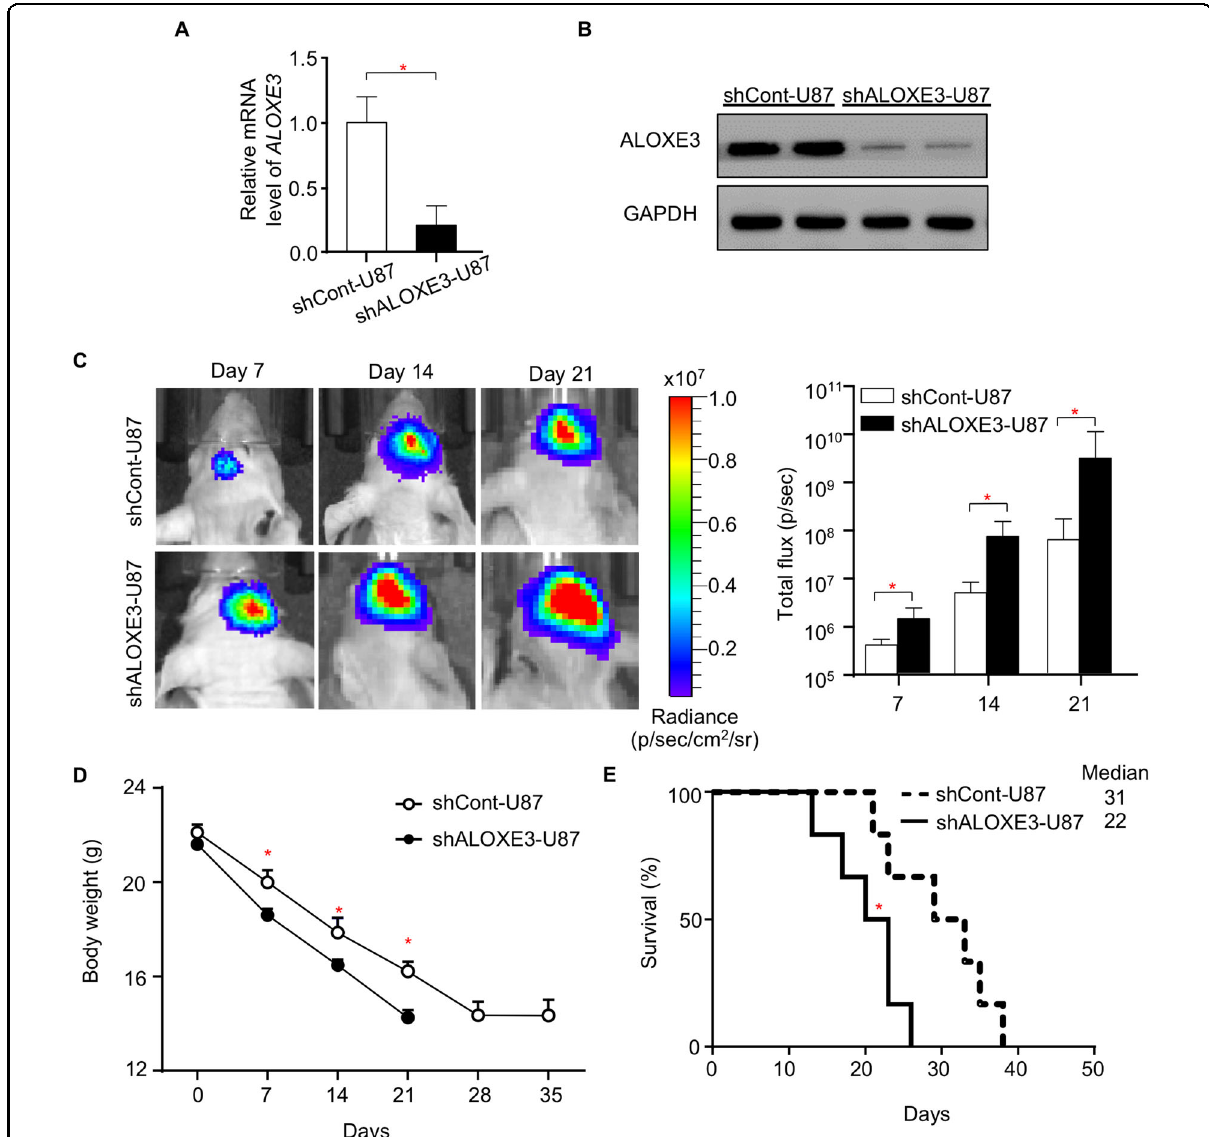
Fig. 2 ALOXE3 de fi ciency promotes orthotopic GBM growth and shortens lifespan in mice. A Relative mRNA level of ALOXE3 normalized with GAPDH in shALOXE3-U87 and shCont-U87 cells ( n = 6). B Immunoblotting analysis of ALOXE3 and GAPDH in shALOXE3-U87 and shCont-U87 cells. Representative immunoblot images are shown ( n = 6). C – E shALOXE3-U87 and shCont-U87 cells were implanted orthotopically into the hippocampus of immunodi fi cient nude mice ( n = 6). C In vivo bioluminescent imaging of nude mice at indicated time points. The right panel is the quanti fi cation of luminescence signal intensity. D Body weight of mice. All data are represented as the mean ± s.e.m. * p < 0.05 (Student ’ s t-test). E Survival curve of mice. Medians are shown. * p < 0.05 (Long-rank